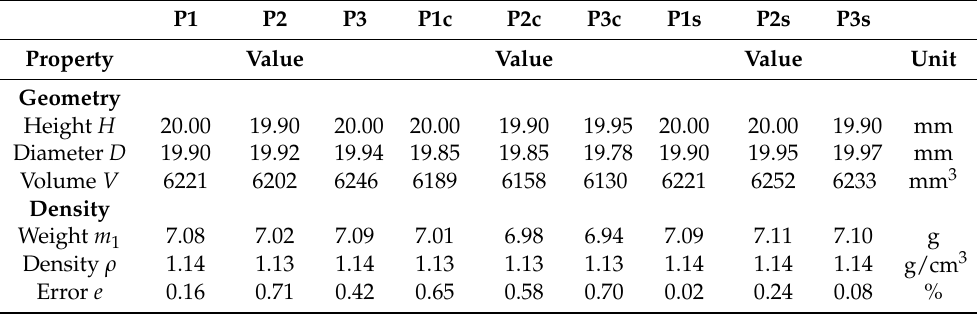
Table 4. Specimen qualifications made with PA6.